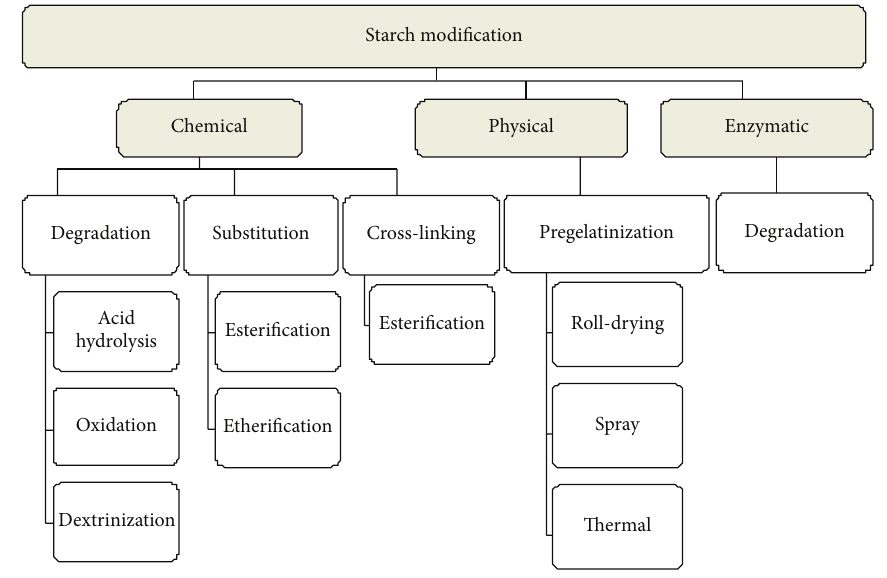
Figure 3: Methods for modification of